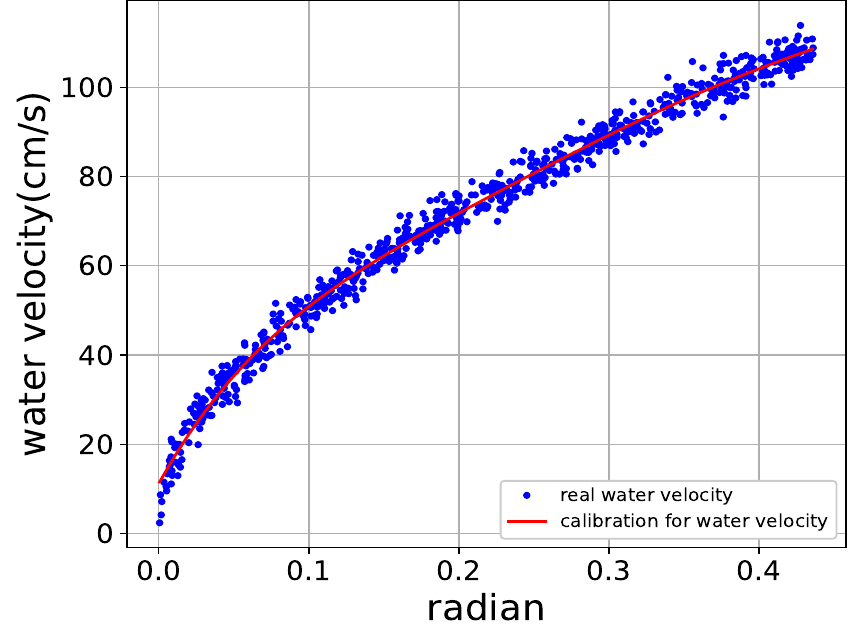
Figure 8. Regression of water